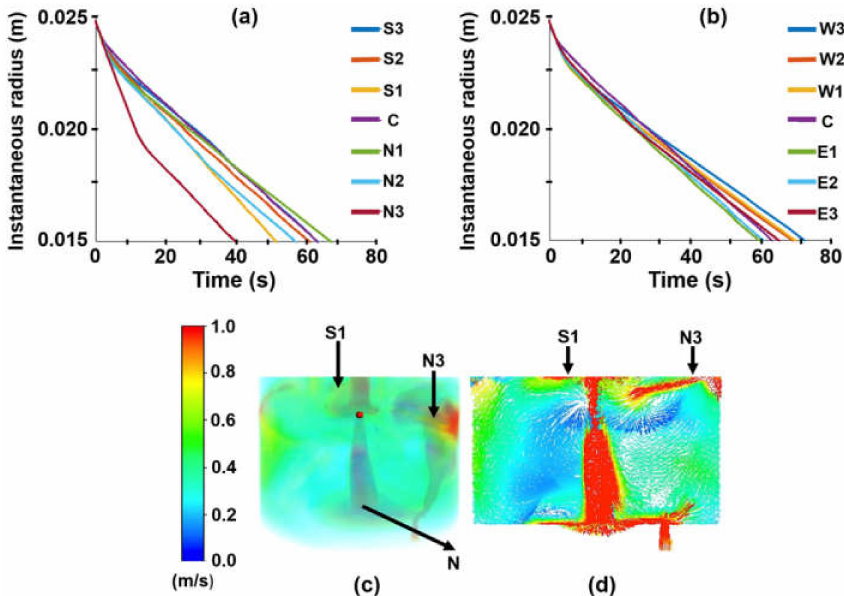
Figure 8. Melting rate of the outer shell and velocity fields in vertical planes at a bath level of 50 tons. ( a ) Axis N–S , ( b ) Axis E–W . Steel superheat is 15 K. ( c ) 3D view of the velocity field. ( d ) Central plane perpendicular to the plane passing through the argon